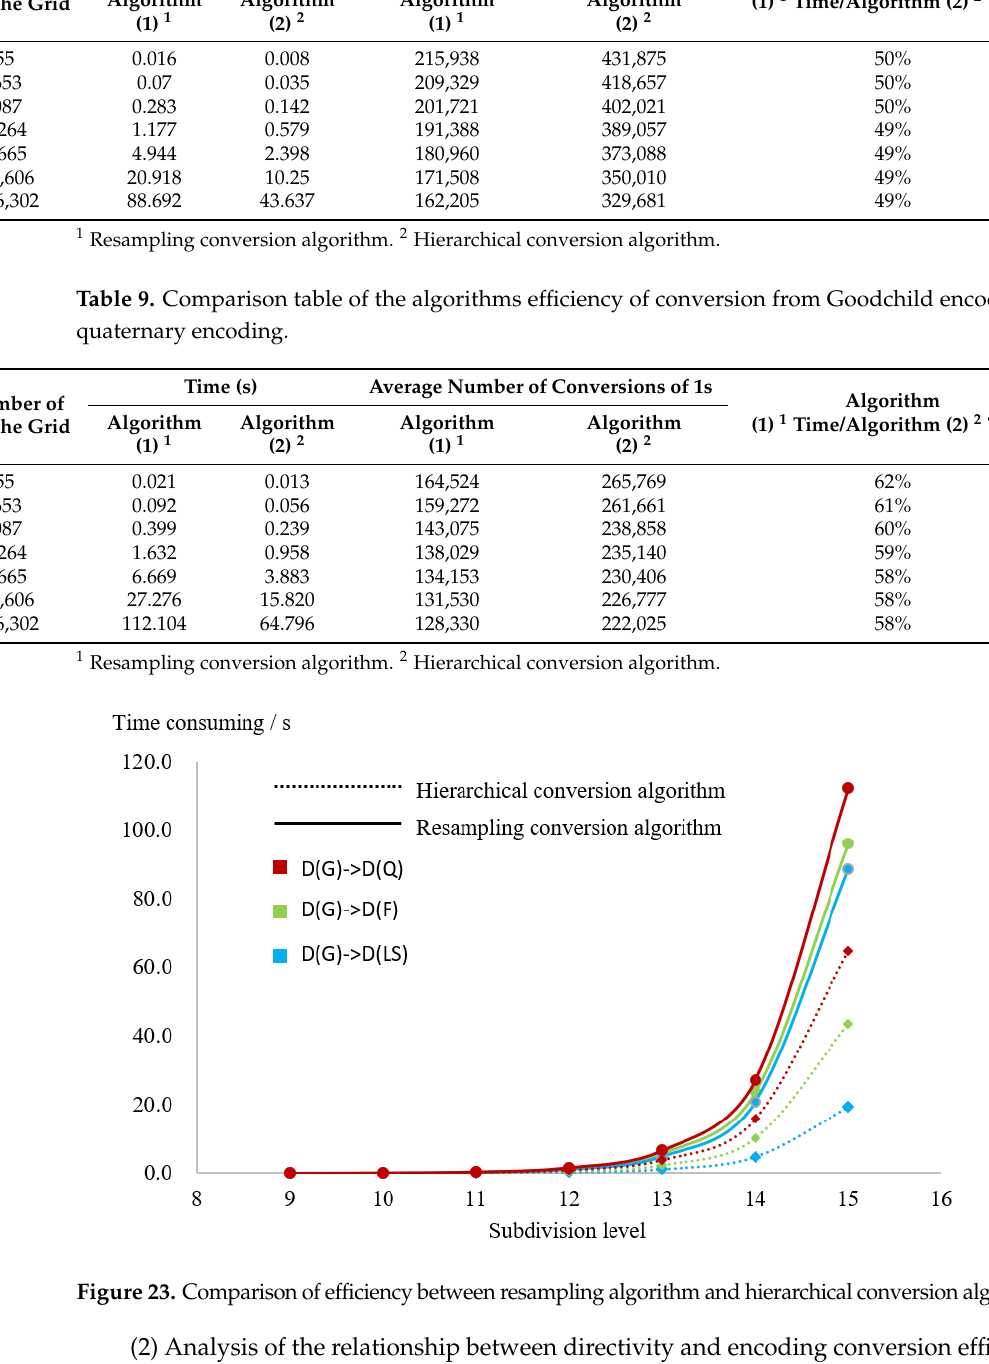
Figure 24. Efficiency of hierarchical conversion algorithms for different types of encoding. 4.2. Comparison and Analysis of Conversion Algorithm Efficiency of Other Types of Encoding For TRQ encoding, it does not have the hierarchical characteristics of triangles, so it is necessary to use the "row–column number" as an intermediary for encoding conversion. Therefore, the row–column conversion algorithm is similar to the resampling algorithm,